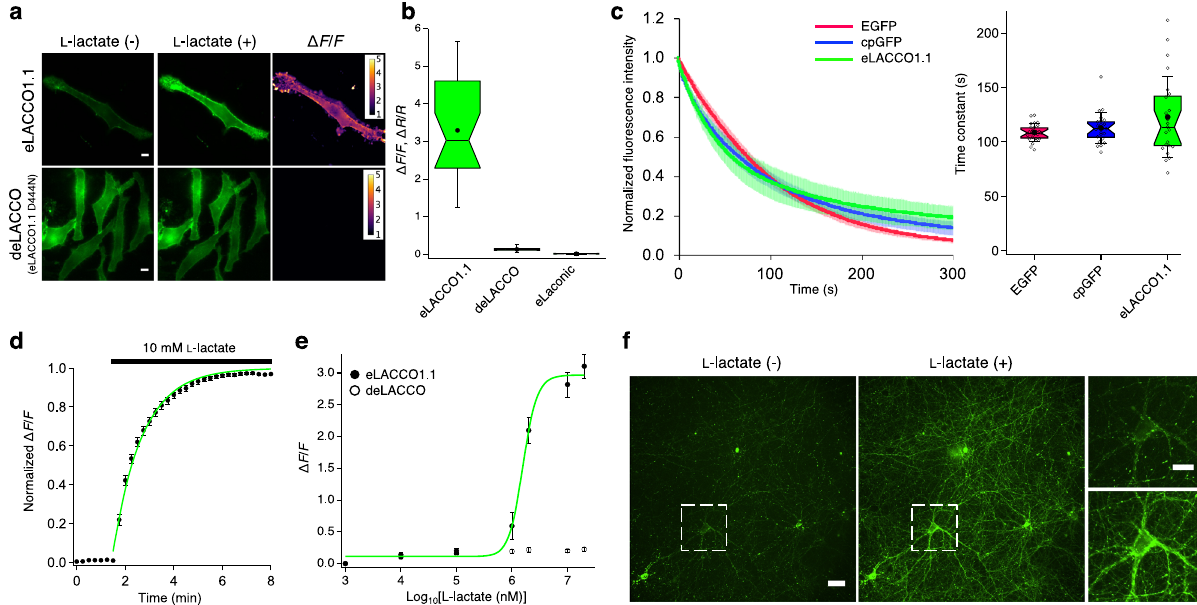
Fig. 4 Characterization of eLACCO1.1 in live mammalian cells. a Representative images of eLACCO1.1 and control biosensor deLACCO expressed on cell surface of HeLa cells before and after 10 mM L-lactate stimulation. Similar results were observed in more than 10 cells. Scale bars, 10 μ m. b Box plots of L - lactate-dependent Δ F / F for eLACCO1.1 and deLACCO, and Δ R / R for eLaconic. n = 26, 28 and 13 cells for eLACCO1.1, deLACCO and eLaconic, respectively. c Photobleaching curves (left) and time constants (right) for EGFP, cpGFP and eLACCO1.1 expressed on the cell surface. To test photostability, we continuously illuminated eLACCO1.1-expressing cells using one-photon wide- fi eld microscopy. n = 25, 24 and 23 cells for EGFP, cpGFP and eLACCO1.1, respectively. In the photobleaching curves, solid lines represent mean value and shaded area represent s.d. One-way ANOVA, P > 0.05. d Time-course of the fl uorescence response of eLACCO1.1 on cell surface under L -lactate stimulation. To examine the on-rate kinetics of eLACCO1.1, we bathed eLACCO1.1- expressing HeLa cells in a solution containing 10 mM L -lactate. The plot was fi tted with a single exponential function. n = 13 cells (mean ± s.e.m.). e In situ titration of L -lactate on HeLa cells. Data were fi tted with Hill equation. n = 11 cells (mean ± s.e.m.). f Representative images of eLACCO1.1 expressed in primary cortical neurons before and after 10 mM L -lactate stimulation. eLACCO1.1 was expressed at relatively high levels, as indicated by bright membrane- localized fl uorescence with some puncta apparent. Similar results were observed in more than 10 neurons from three independent experiments. Scale bars, 10 μ m. In the box plots in b , c , the narrow part of notch with the horizontal line is the median; the top and bottom of the notch denote the 95% con fi dence interval of the median; the top and bottom horizontal lines are the 25th and 75th percentiles for the data; and the whiskers extend one standard deviation range from the mean represented as black fi lled circle. Source data of b – e are provided as a Source Data fi